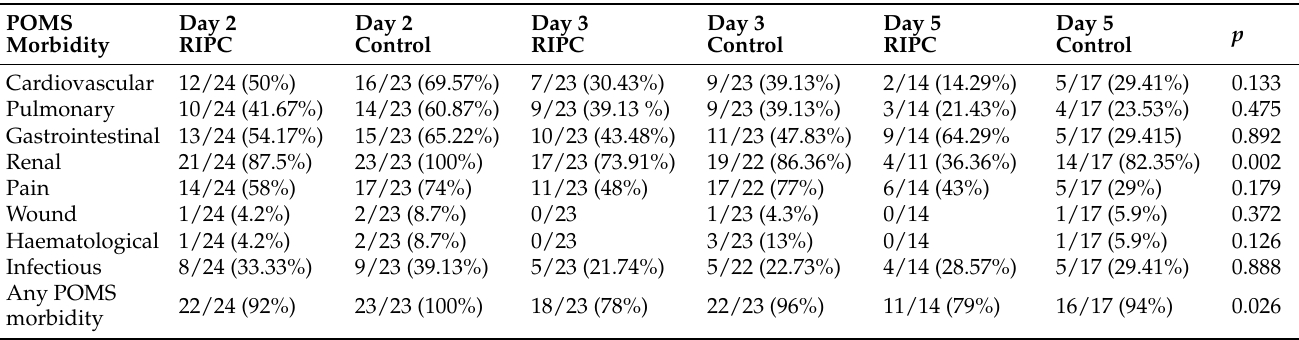
Table 2. Postoperative Morbidity Survey (POMS) on days 2, 3 and 5 in the remote ischaemic preconditioning (RIPC) and the Control group. The p values are derived from Cochran–Mantel– Haenszel tests comparing the development of complications between the intervention and control groups stratified by